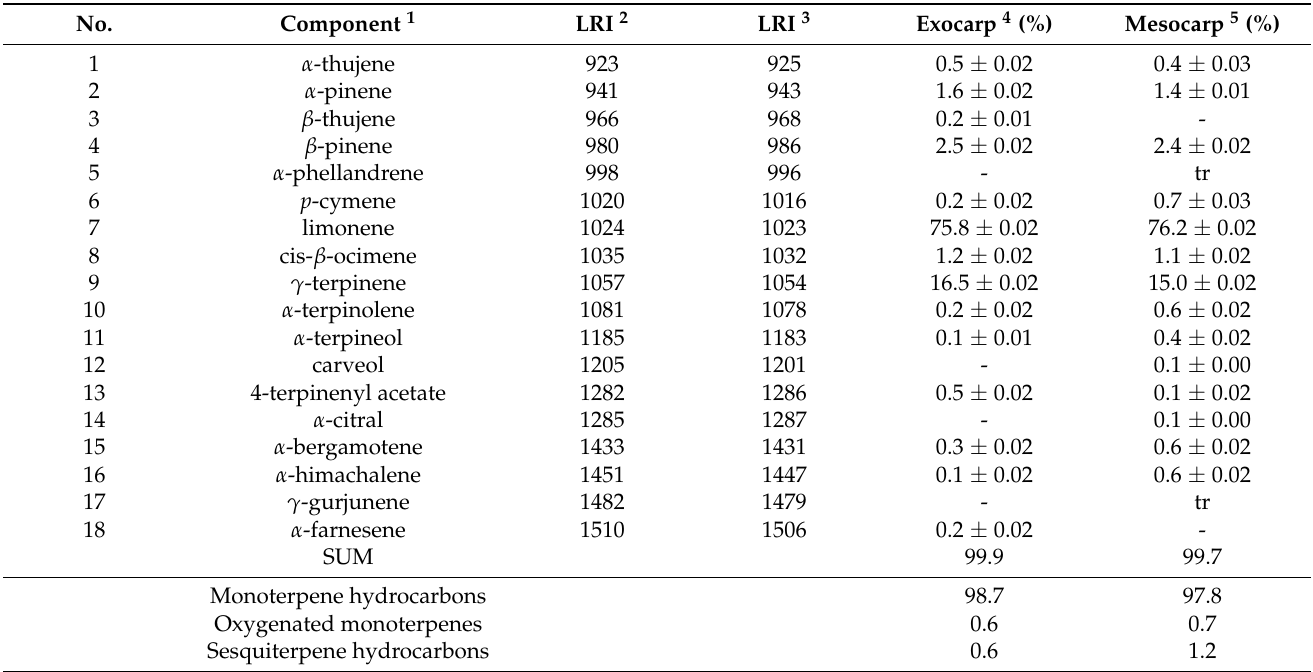
Table 1. Chemical composition (percentage mean value ± standard deviation) of exocarp and mesocarp.